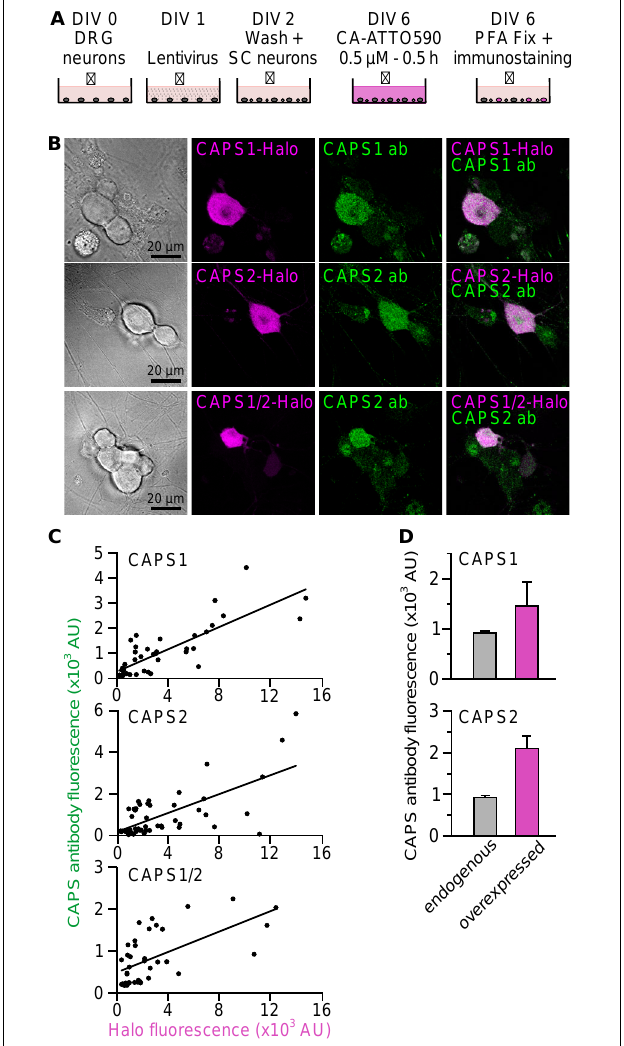
FIGURE 3 | All CAPS-Halo constructs are equally expressed to twice the endogenous level. (A) Schematic staining protocol. DRG neurons were isolated from CAPS dKO mice and SC neurons were prepared from WT mice. (B) DRG CAPS dKO neurons expressing CAPS1-, CAPS2b-, or CAPS1/2 chimera-Halo stained with CA-ATTO590 (magenta) and immuno-labeled with anti-CAPS1 or CAPS2 antibody (green). (C) Correlation plot of CAPS1 or CAPS2 antibody fluorescence intensities against CA-ATTO 590 ( n = 42, n = 52, and n = 39 for CAPS1, CAPS2, and CAPS1/2 chimera, respectively, N = 3). (D) Mean endogenous CAPS expression level measured in wild type neurons (gray bar) compared to overexpressed CAPS-Halo level (magenta bar). Top and bottom graph represent CAPS1 and CAPS2, respectively ( n = 15 and n = 8 for endogenous vs. overexpressed CAPS1 and n = 16 and n = 18 for endogenous vs. overexpressed CAPS2, respectively; N experiment =